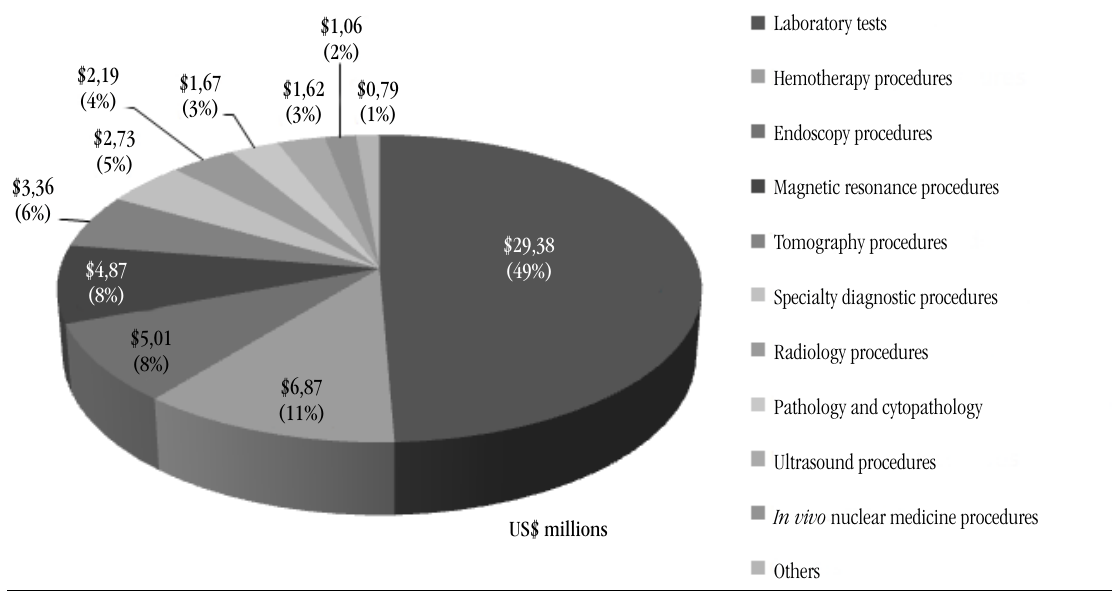
figurE 4 – Distribution of SUS expenditures according to the type of outpatient diagnostic procedure in the studied cities, 2011 (US$ million) Source: DATASUS, 2012 (12)